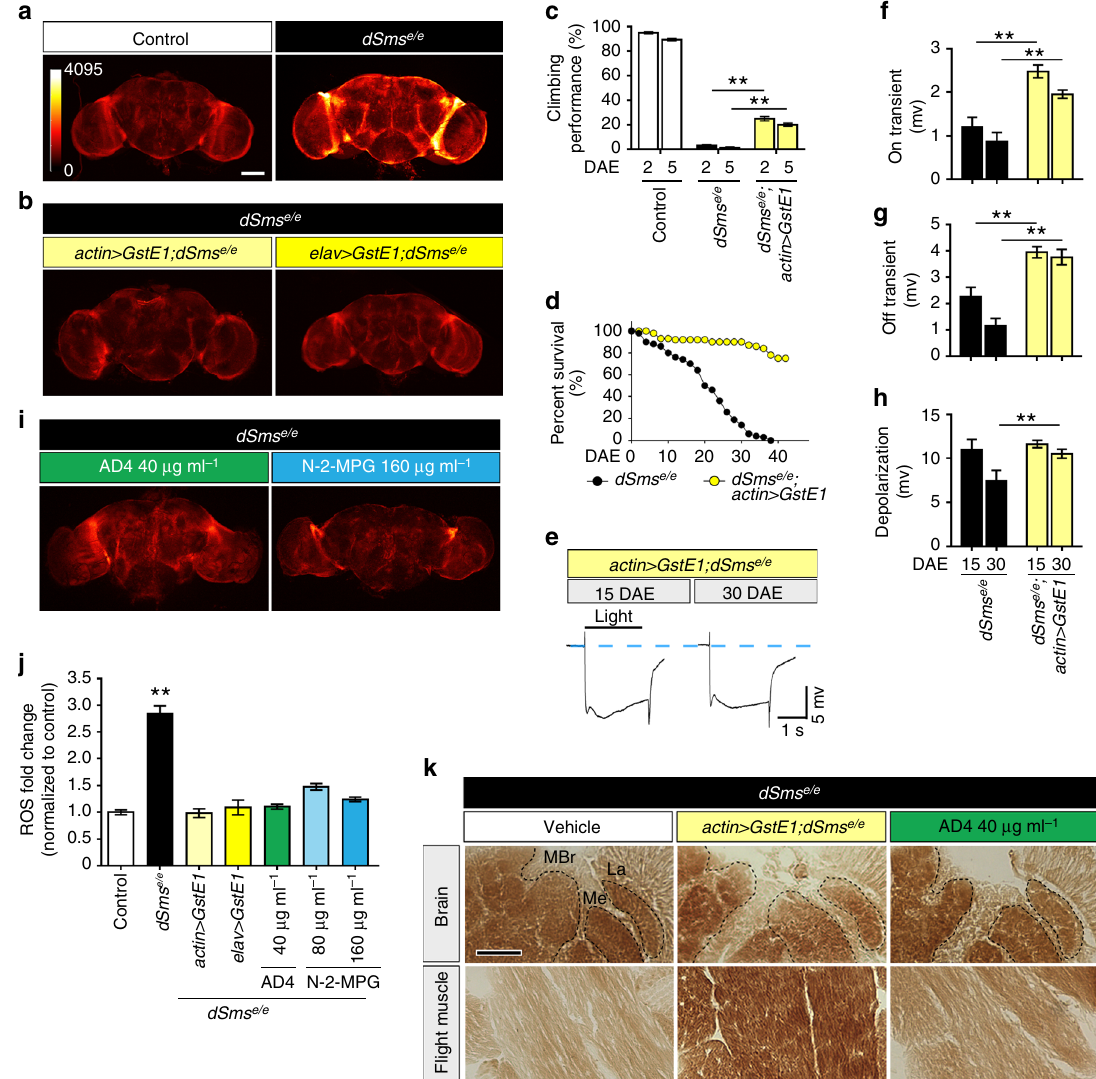
Fig. 7 Oxidative stress caused by spermidine catabolism is suppressed through genetic or pharmacological enhancement of antioxidant capacity. a , b DHE staining (intensity indicated with heat map) showing ROS levels in fl y brains. Note the increased fl uorescence intensity in the mutant brains, which can be suppressed by ubiquitous ( actin-gal4 ) or neuronal ( elav-gal4 ) overexpression of GstE1. Quanti fi ed in f . Scale bar, 100 µ m. c Climbing performance of control, dSms e/e , and dSms e/e fl ies ubiquitously overexpressing GstE1 at of 2 and 5 DAE (mean ± S.E.M.; each data point obtained from a group of 10 animals, n = 10 experiments). d Fly survival curves ( n = 62 for dSms e/e and 66 for GstE1 rescue fl ies) determined by the age-speci fi c number of live individuals. e Representative traces from ERG recordings showing light-induced depolarization and on/off responses. f – h Quanti fi cation (mean ± S.E.M.; n = 10 ( dSms e/e , 15 DAE), 10 ( dSms e/e , 30 DAE), 11 ( actin > GstE1 , 15 and 30 DAE) fi eld recordings from 4 – 5 animals) of on transient ( f ), off transient ( g ), and depolarization ( h ) of ERG at different ages. i DHE staining showing ROS levels in brains of 5 DAE mutant fl ies raised on antioxidants at different concentrations. See a for staining of untreated mutant fl ies. j Quanti fi cation of ROS levels ( n = 12 (control), 12 ( dSms e/e ), 5 ( actin > GstE1 ), 5 ( elav > GstE1 ), 9 (AD 40 μ g ml − 1 ), 5 (N-2-MPG 80 μ g ml − 1 ), 5 (N-2-MPG 160 μ g ml − 1 ) animals from each group; mean ± S.E.M.) normalized to control brain. k Histochemical analysis of COX activity in brain and fl ight muscle. Black dashed outline delineates different brain regions. MBr middle brain, Me